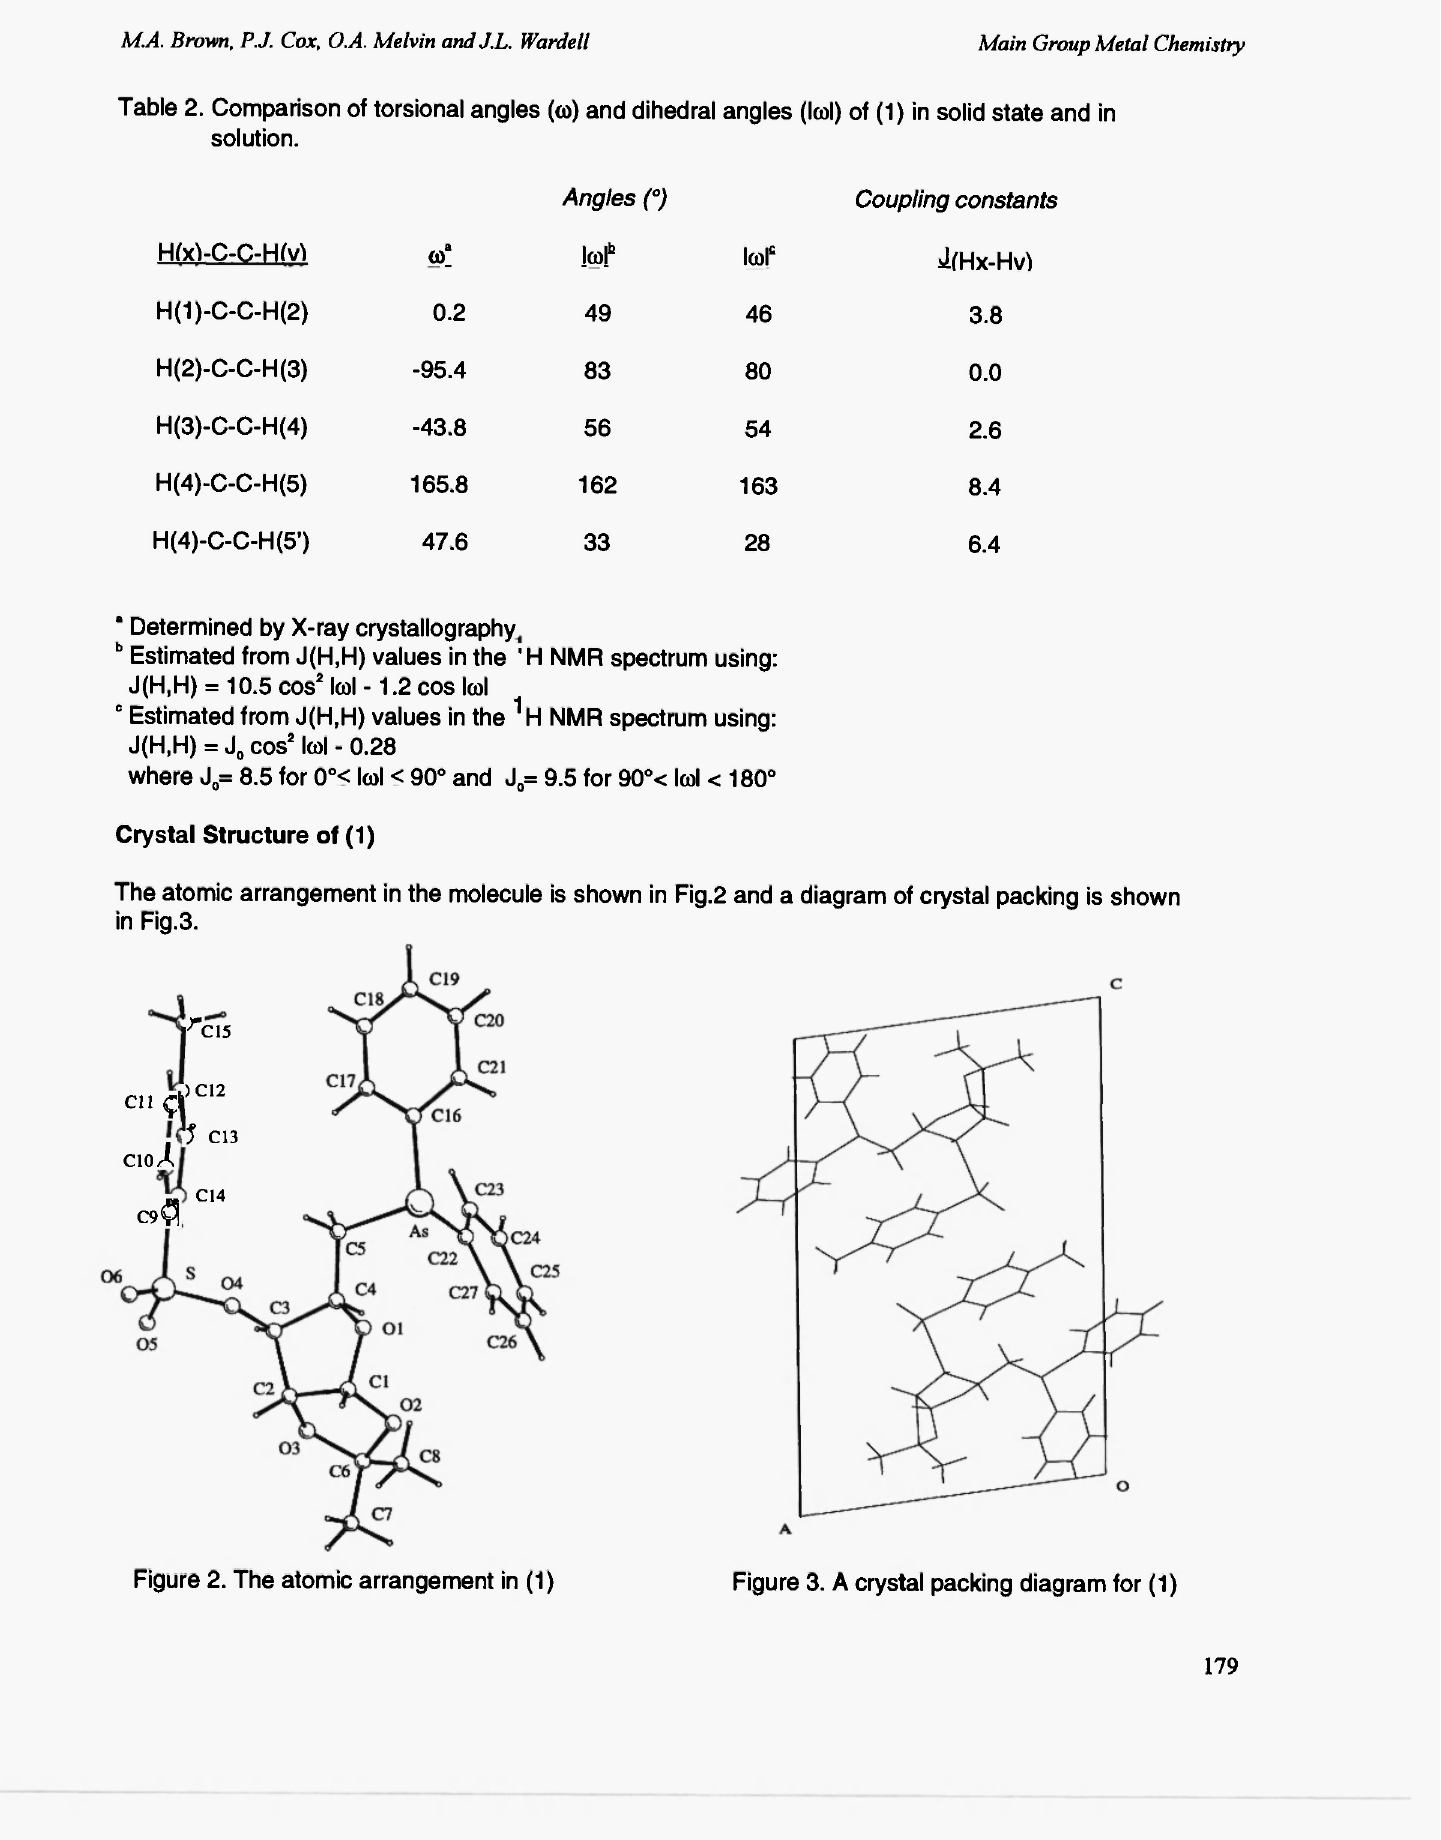
Figure 2. The atomic arrangement in (1) Figure 3. A crystal packing diagram for